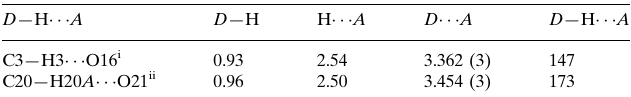
Hydrogen-bond geometry (A˚ , (cid:2) ).